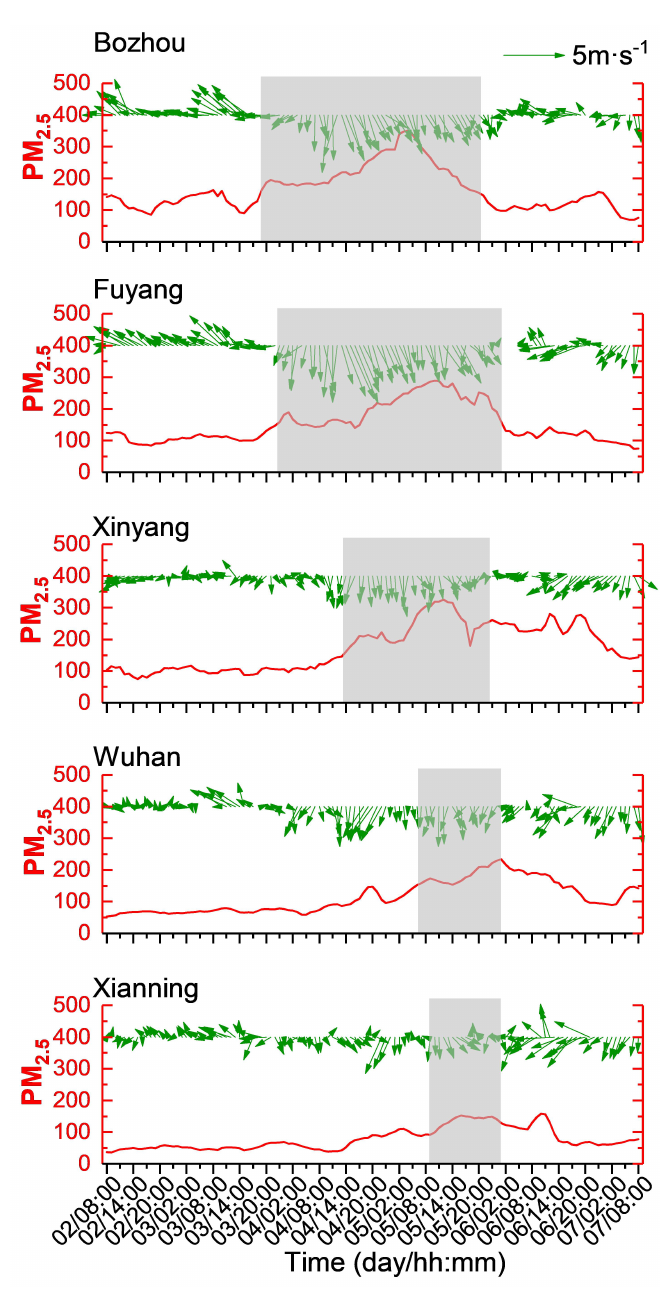
Figure 7. Hourly variations of the surface PM 2.5 concentration ( µ g · m − 3 ) and 10 m wind (m · s − 1 ) observed at Bozhou, Fuyang and Nanyang stations in the upwind direction and at Wuhan and Xianning stations in the downwind direction during 2–7 January 2019. The green arrows represent 10 m wind at five observation